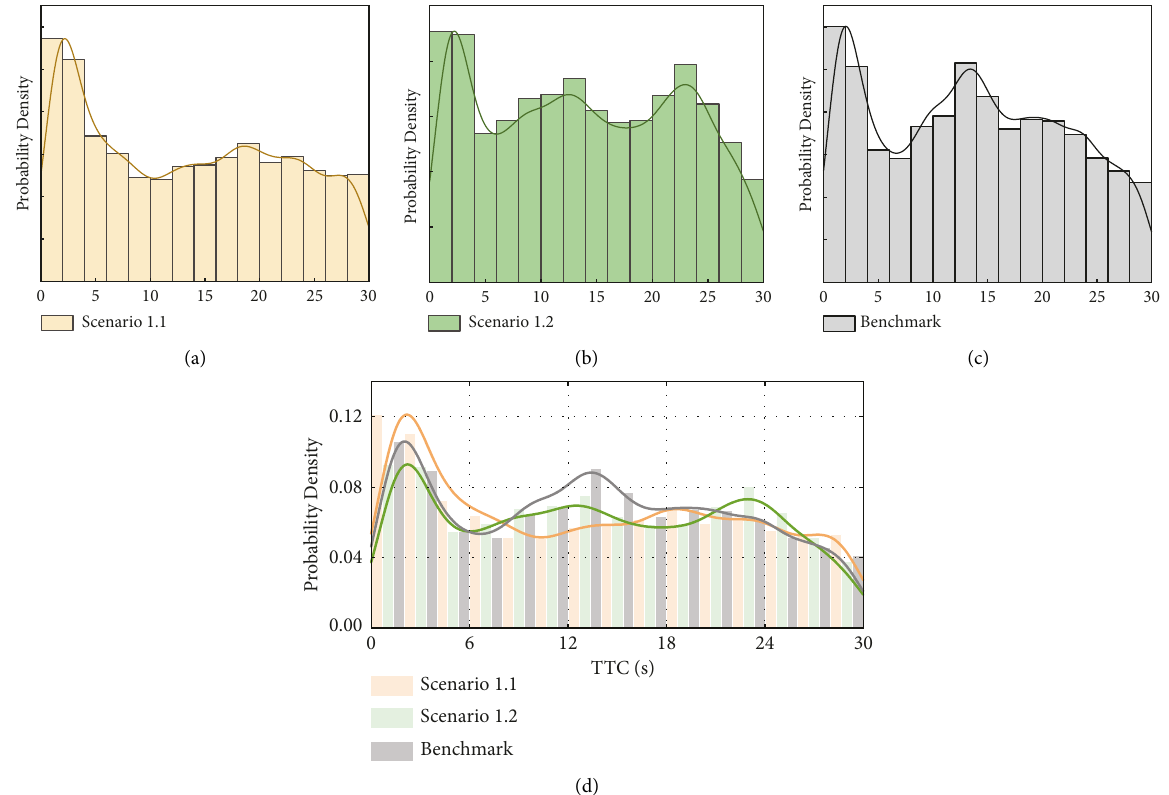
Figure 6: The results for the first simulation under TTC: (a) the probability density of TTC in scenario 1.1, (b) the probability density of TTC in scenario 1.2, (c) the probability density of TTC in the benchmark scenario, and (d) the comparison of the three